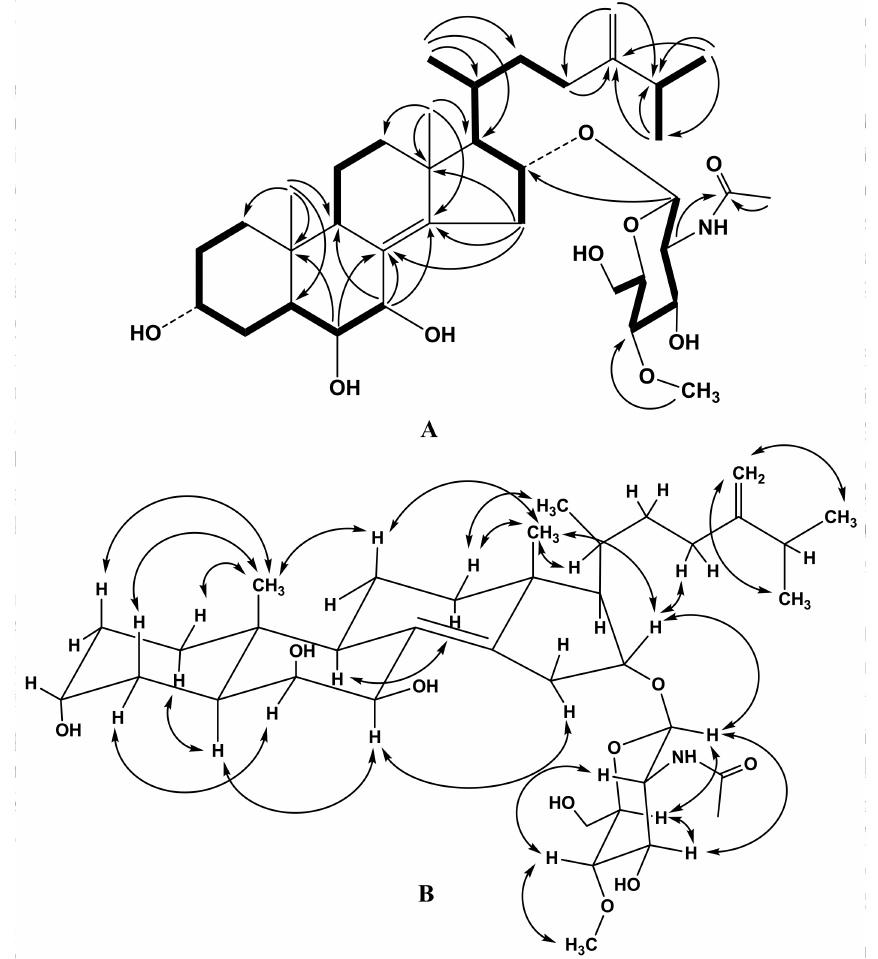
Figure 2. ( A ) 1 H- 1 H COSY and key HMBC correlations for compound 1 . ( B ) Key ROESY correlations for compound 1